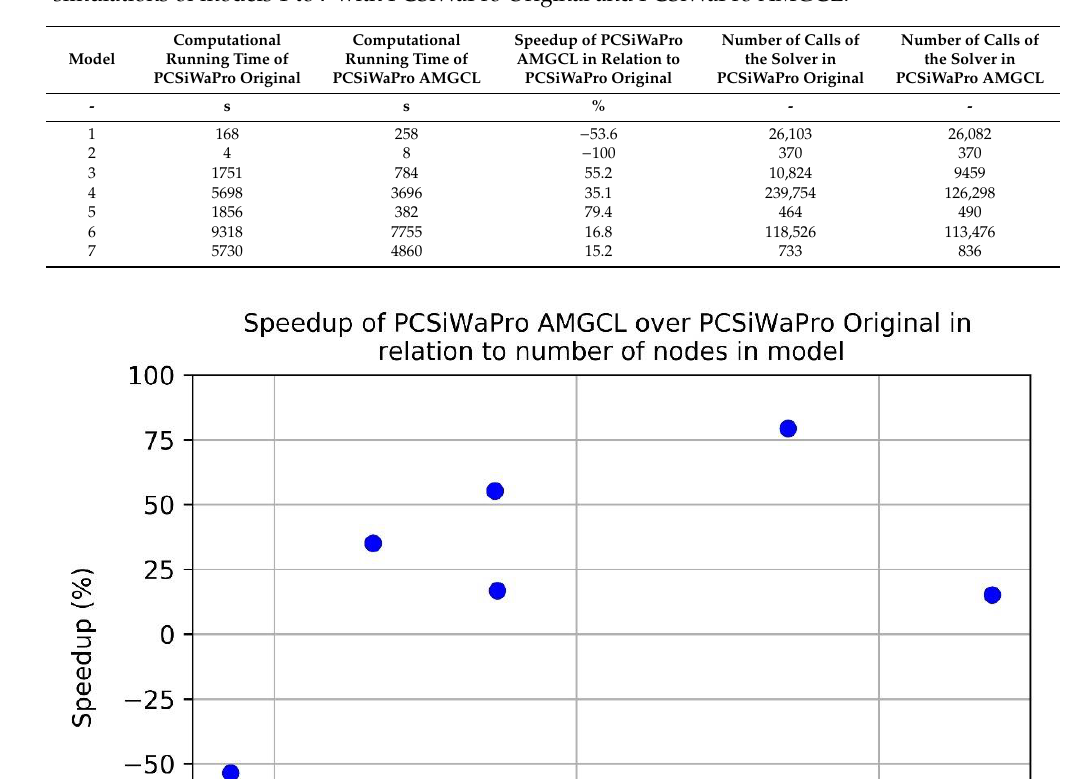
Table 2. Overview over the computational running time and the number of calls of the solver of the simulations of models 1 to 7 with PCSiWaPro Original and PCSiWaPro AMGCL.